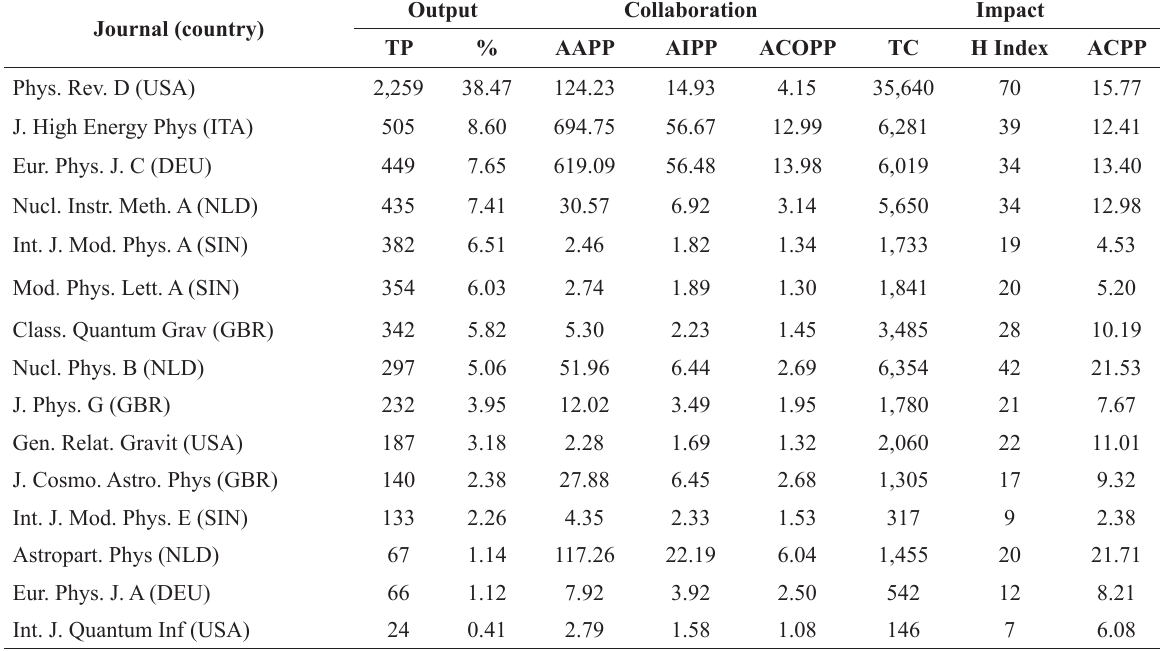
Fifteen main journals for Brazilian HEP scientific output,